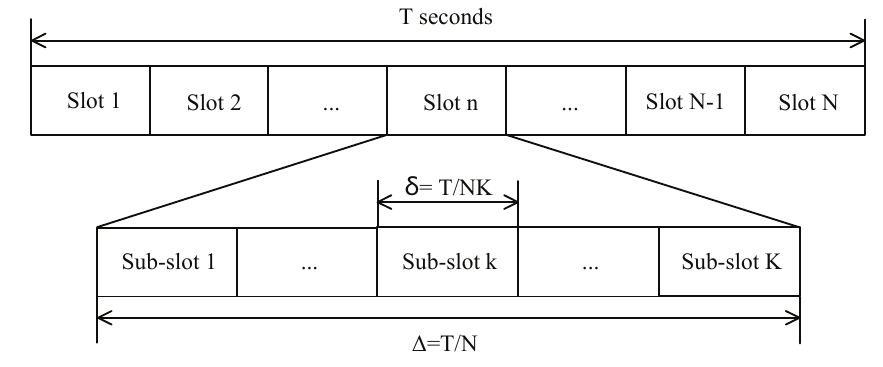
Figure 2. The slots and sub-slots in time division multiple access